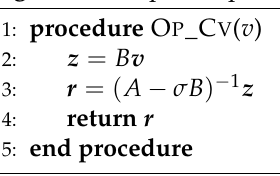
Algorithm 3 Op_Cv